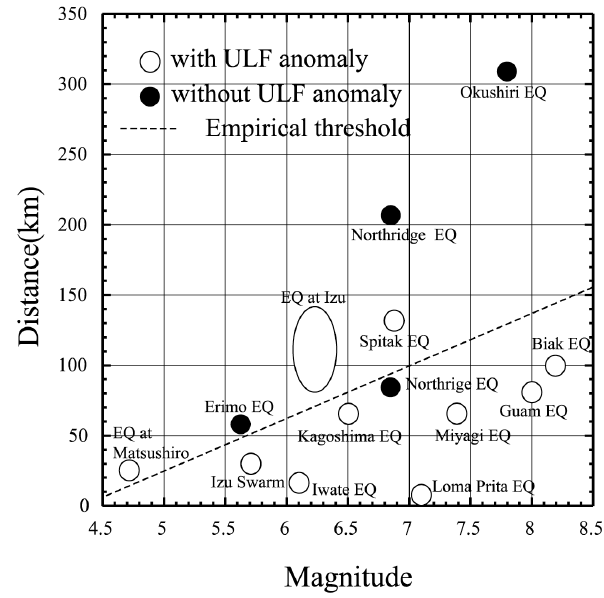
Figure 2. Summary of the seismo-ULF emissions in the form of earthquake magnitude (M) and epicentral distance (R). A white circle means the event with ULF anomaly, while a black circle, the event without ULF anomaly. The empirical threshold is indicated by a dotted line (0.025R=M-4.5). It is important to predict earthquakes with M 6 in a highly populated region to mitigate